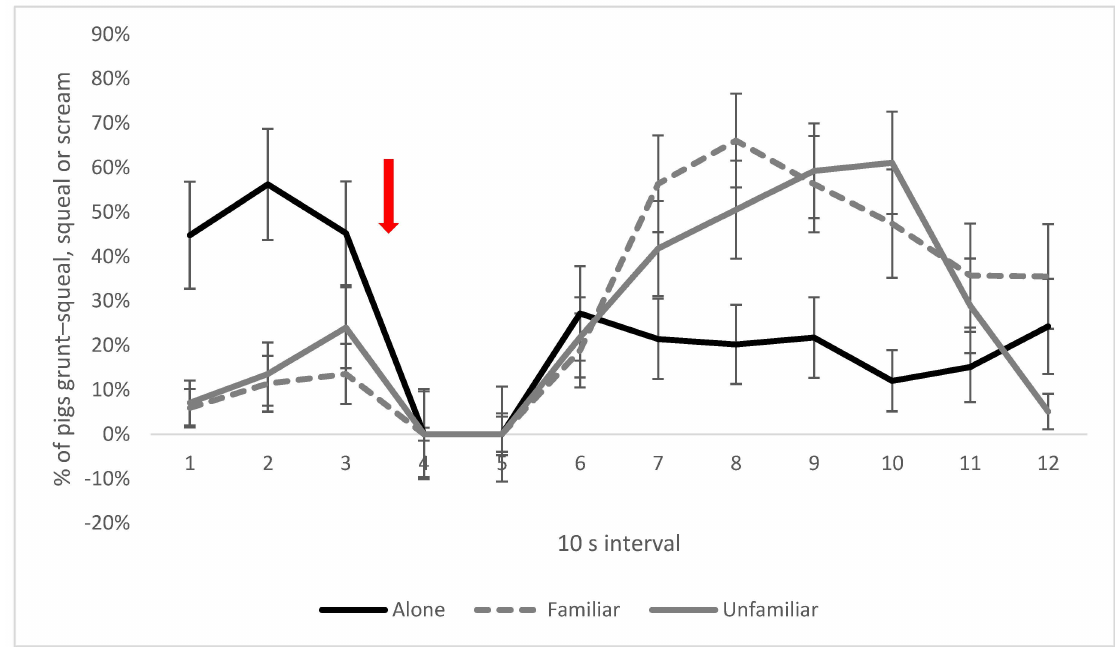
Figure 4. Percentage (%) of pigs vocalising with high-frequency grunt − squeals, squeals, or screams at least once per interval in the social treatments. Red arrow indicates time of foam start. Values given are LSM ± SE. Lack of overlap of SE error bars indicates significant pairwise difference ( p < 0.05) between treatments or over time between intervals. Overall p − value for the interaction: p <